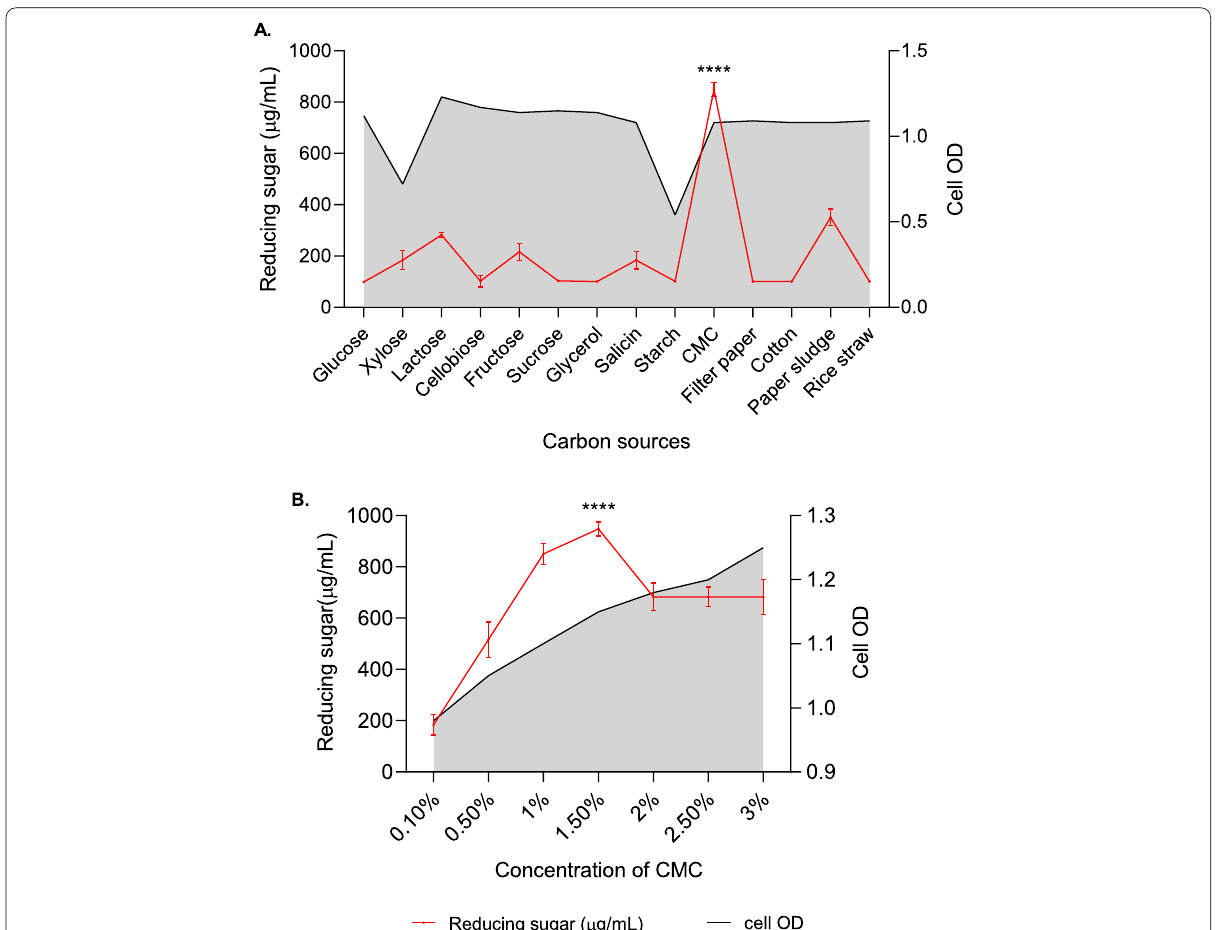
Fig. 3 Effect of A different carbon sources and B different concentrations of CMC on the production of reducing sugar by Arthrobacter woluwensis TDS9. Incubation of the culture was performed at 25°C for 72 h maintaining the initial medium pH 8. Cell OD was measured at 600nm wavelength. **** indicates statistical significance value, P <